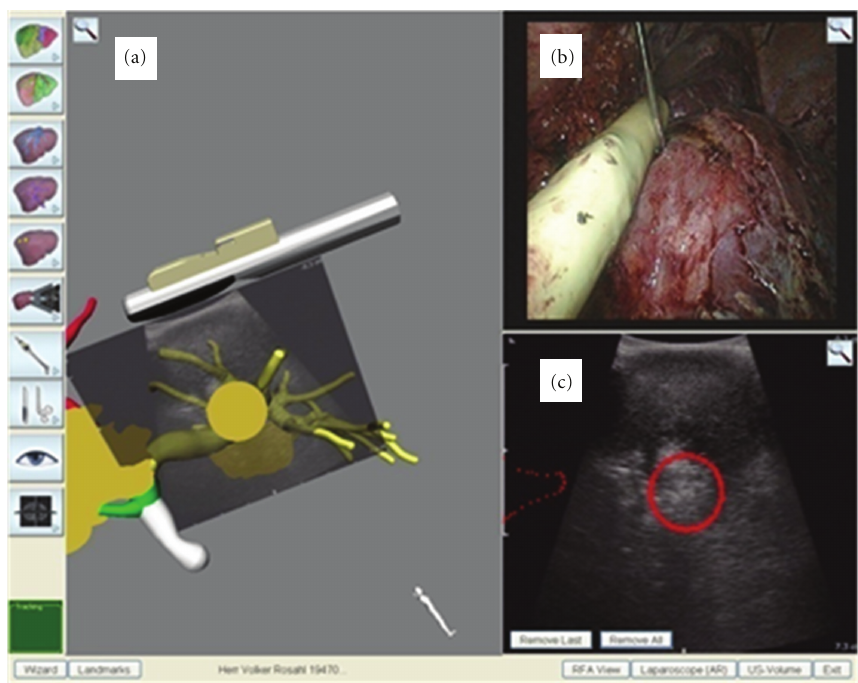
Figure 2: (a–c) Screen shot of the LapAssistent with simultaneous presentation of (a) virtual reality navigation with registered intraoperative B-Mode ultrasound picture to the preoperative 3D-MRI-planning data, (b) real-time laparoscopic video screen imported from surgical laparoscopic imaging device, and (c) real-time ultrasound B-Mode picture with overlapping tumor.